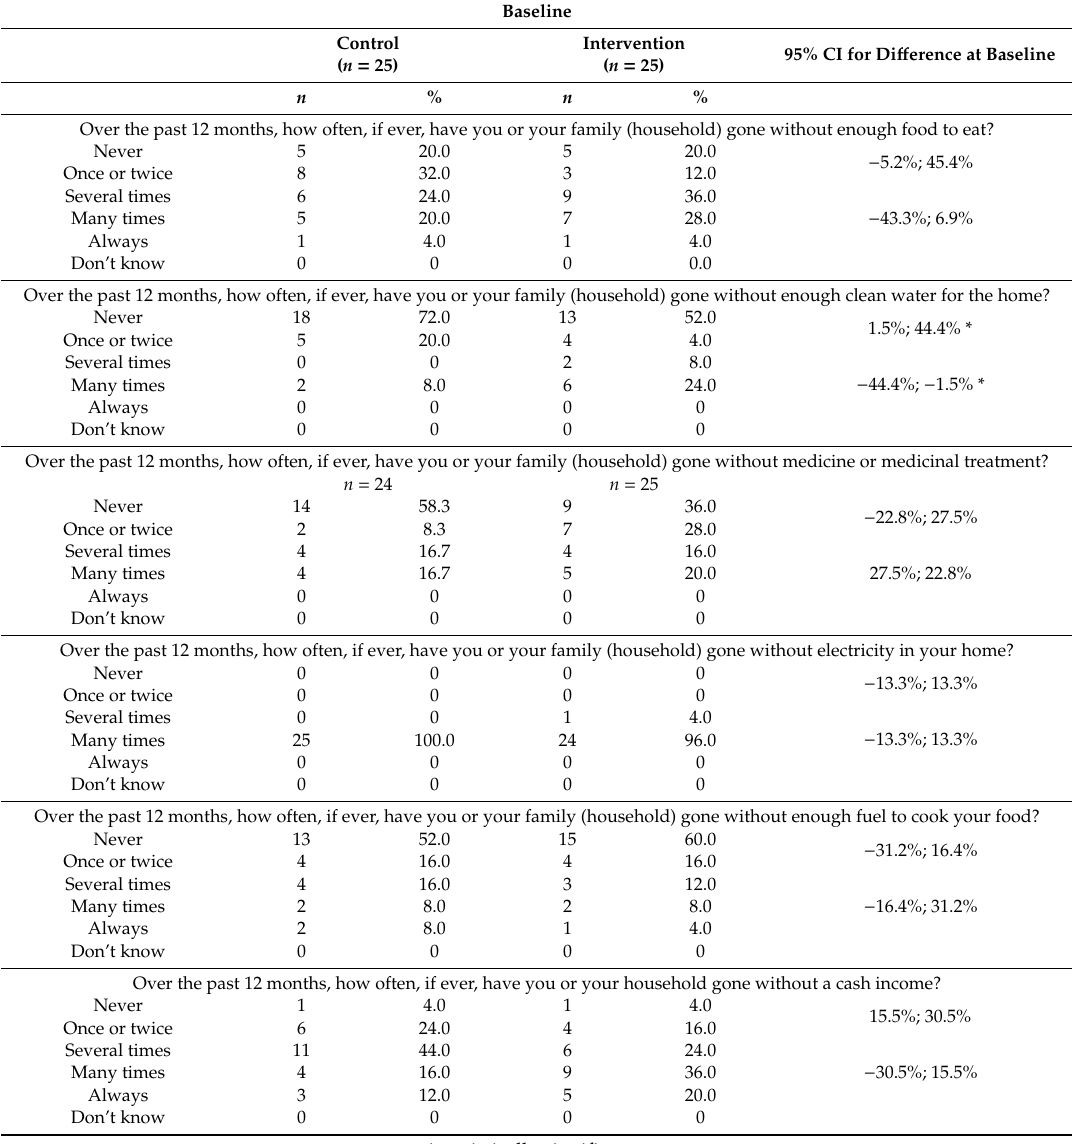
Table 2 indicates the results pertaining to the categories of LPI of the control and intervention groups. Table 2. Living Poverty Index of control and intervention groups at baseline. Baseline Control Intervention 95% CI for Di ff erence at Baseline ( n = 25) ( n = 25) n %